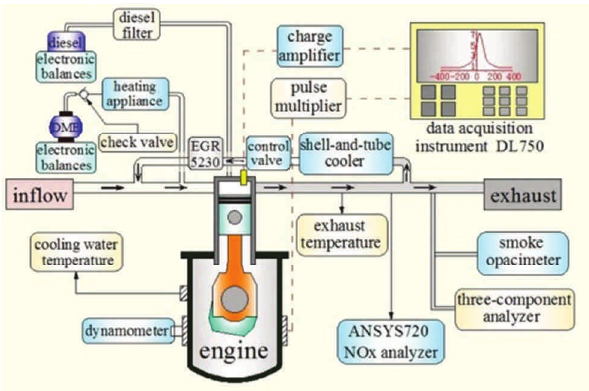
Fig. 3. Experimental DME fuel systems with indirect liquid injection before valves